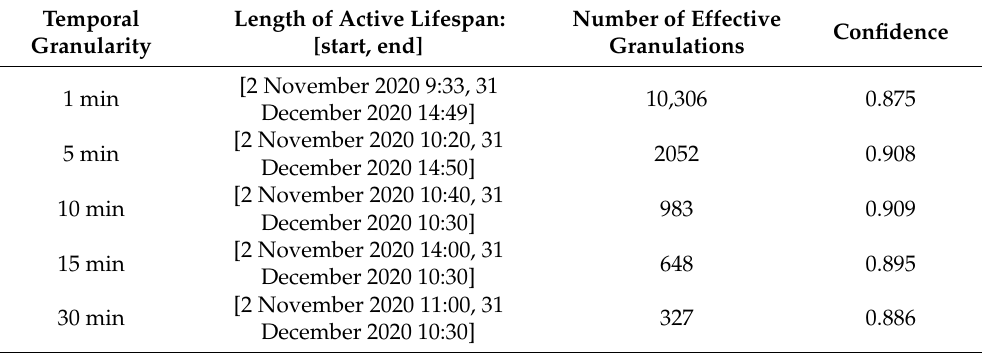
Table 5. Comparison of confidence for different temporal granularities of rule (12 →